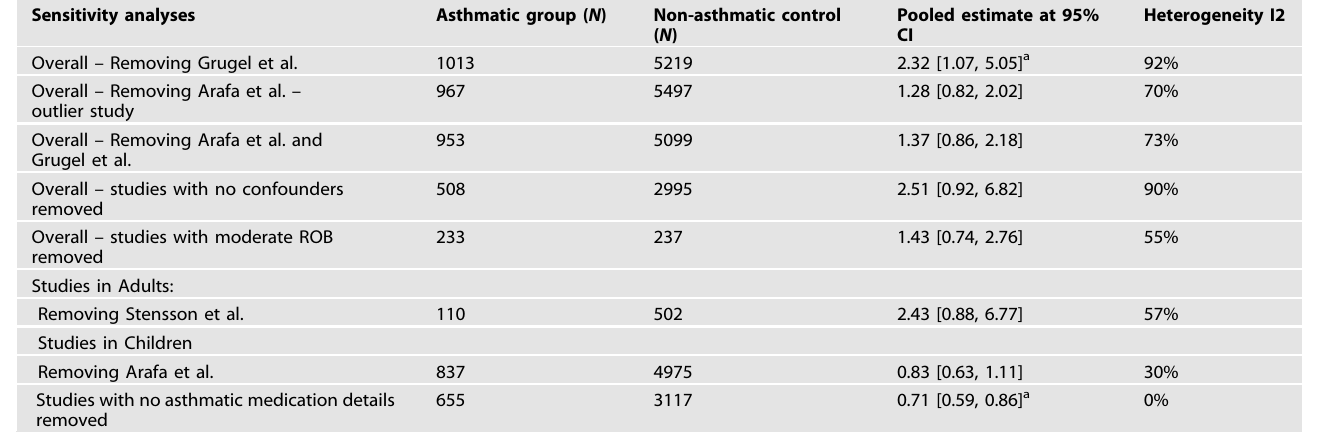
Table 3. Sensitivity